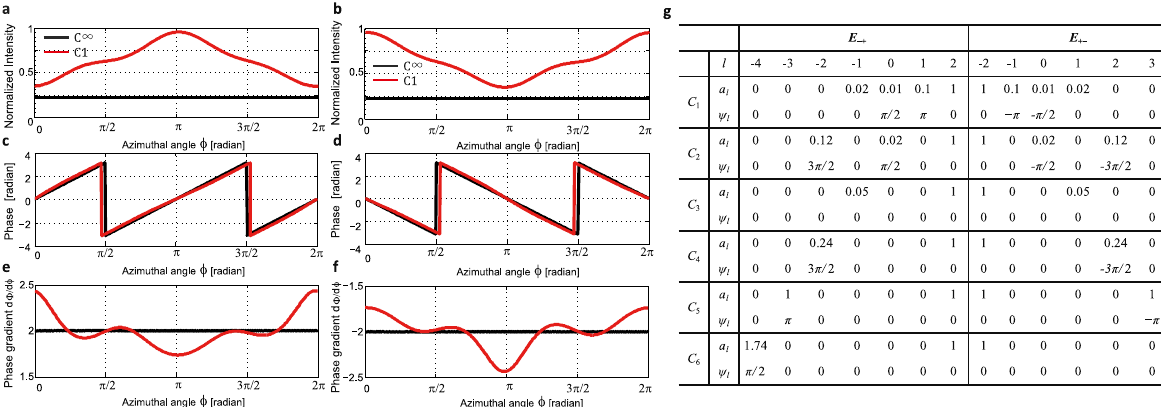
Figure 5: Analytically calculated intensity, phase, and phase gradient as a function of the azimuthal angle ϕ . (a, b) Calculated far- fi eld intensity I ij . (c, d) Calculated phase Φ ij . (e,f) constant phase gradient d Φ ij / d φ of C ∞ h (black) and nonuniform phase gradient of C 1 h (red). The plots are for { ij } con fi guration, where { ij } are detection and incidence circular polarization helicity, { − +} for (a, c, e) and {+ − } for (b, d, f). Non- constant phase gradient takes place owing to ϕ -dependent ∇ ϕ Φ D ( ϕ ) . (g) Fit values of partial-wave expansion coef fi cient ˜ a l , the l th order expansion coef fi